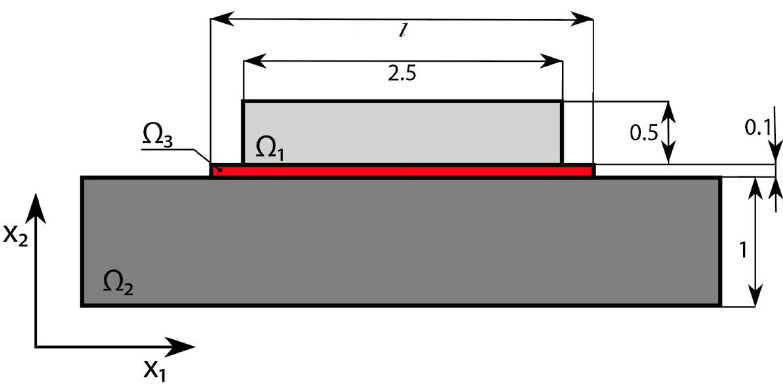
Figure 5. Construction of the non-symmetric package (Unit: mm).